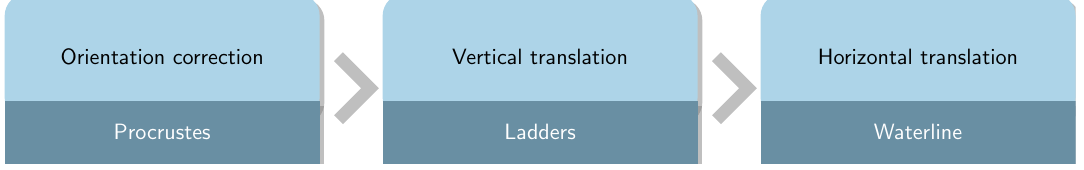
Figure 12. Flow chart of the registration of a sonar point cloud on a laser point cloud.